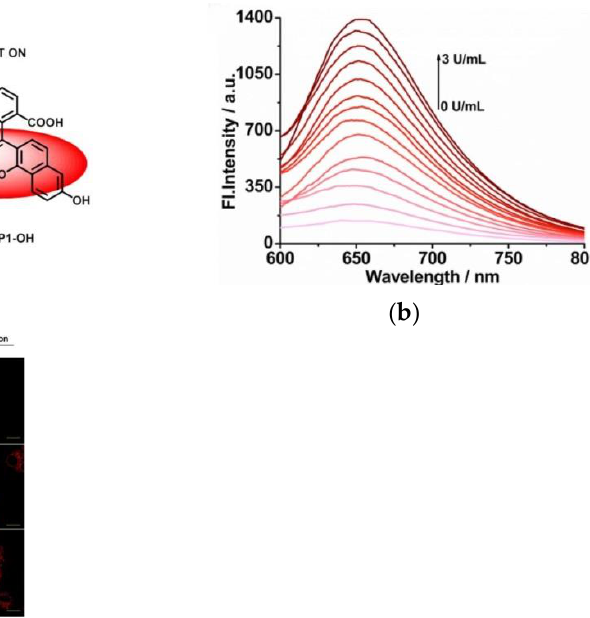
Figure 11. ( a ) Design of probe P1 and its sensing principles; ( b ) Fluorescence spectra of P1 toward series concentrations of NTRs in the being of NADH; ( c ) Fluorescent images for tracing NTRs in HepG2 cells. Reproduced with permission from [63]. Copyright 2021 Elsevier B.V.